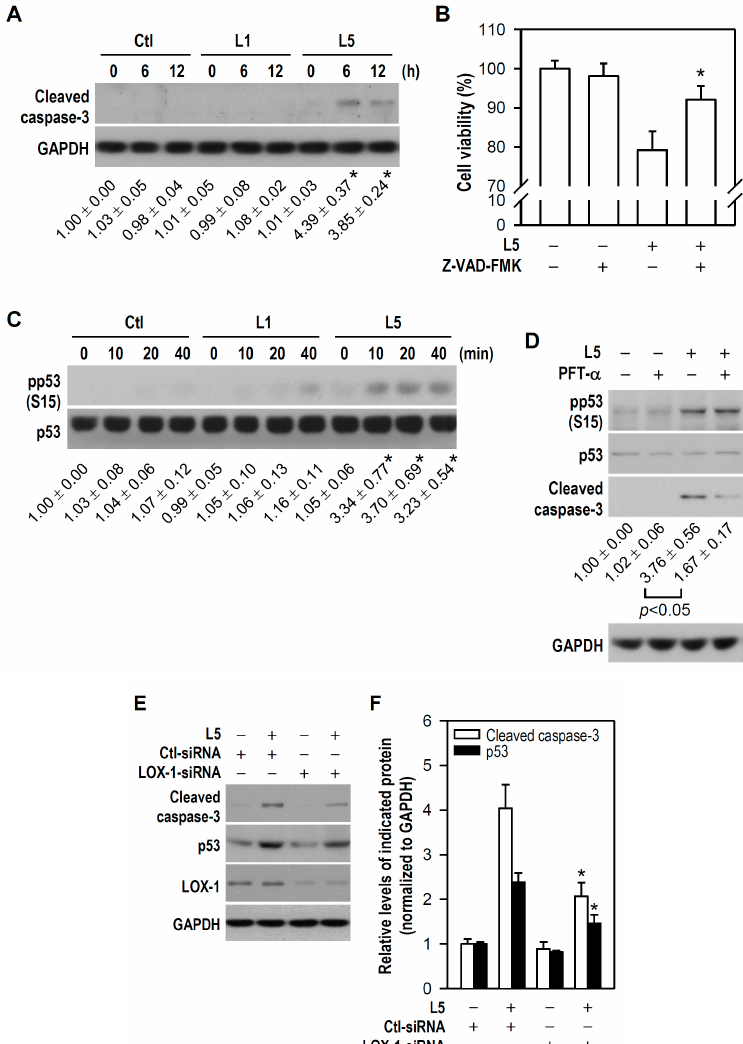
Figure 4. Reduced viability of L5-treated PC12 cells is associated with LOX-1 expression, p53 activation, and caspase-3 cleavage. ( A ) Cultures were treated with L1 or L5 (30 μ g/mL) for the indicated times and then western blotting was used to detect cleaved caspase-3. Untreated cells were used as a control. GAPDH was a protein loading control. Quantitative values are expressed relative to untreated control at a time point of 0 h (assigned a value of 1); the means ± SEM from four independent experiments are shown below the representative blots. * p < 0.05 vs. Ctl at the same time point; ( B ) Cells were treated with or without L5 (30 μ g/mL) for 12 h in the absence or presence of a pan-caspase inhibitor Z-VAD-FMK (20 μ M). The histogram shows the cell viability of each treatment group relative to the untreated control (assigned a value of 100%). Data are presented as mean ± SEM from at least three independent experiments performed in triplicate. * p < 0.05 vs. L5 alone; ( C ) After the indicated treatments, western blotting was used to detect pp53 and p53 expression. Quantitative results of relative pp53 levels from four independent experiments are shown below the representative blots. * p < 0.05 vs. Ctl at the same time point; ( D ) Before sham or L5 (30 μ g/mL) treatment for either 20 min or 12 h, cells were pretreated with or without PFT- α (10 μ M) for 1 h. The expression of pp53 and p53 (at 20 min), and cleaved caspase-3 (at 12 h) was detected by western blotting. Relative quantitative results of cleaved caspase-3 from four independent experiments are shown below the representative blots; ( E ) One day after transfection with a scrambled siRNA (Ctl-siRNA) or a LOX-1-siRNA, cultures were treated with or without L5 for 12 h. Cleaved caspase-3, p53, and LOX-1 were detected by western blotting and representative blots are presented; and ( F ) Relative quantitative expression of cleaved caspase-3 and p53 in ( E ) is shown by a histogram. Data are from four independent experiments. * p < 0.05 vs. Ctl-siRNA + L5.